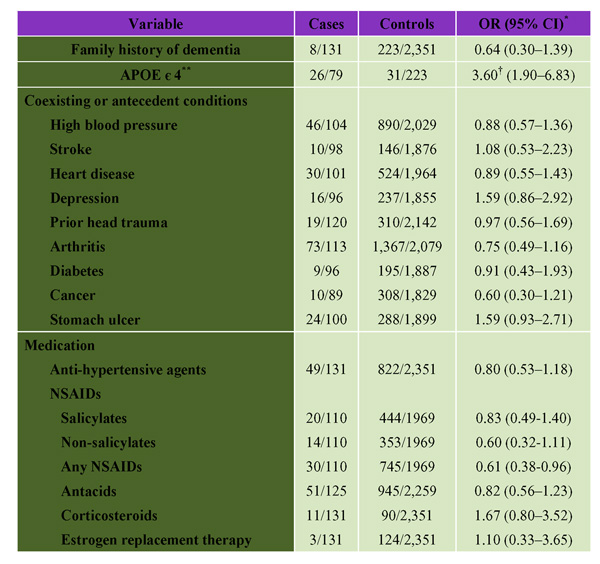
Association of family history of dementia, APOE ε4 status, coexisting or antecedent selected diseases, and prior use of medication with risk of AD, Canadian Study of Health and Aging, women, 1996.APOE = apolipoprotein E;   NSAIDs = Non-steroidal anti-inflammatory drugs.OR = odds ratio;   CI = confidence interval.  * Adjusted for age and education. ** Comparison group is E3/E3.  † Statistically significant